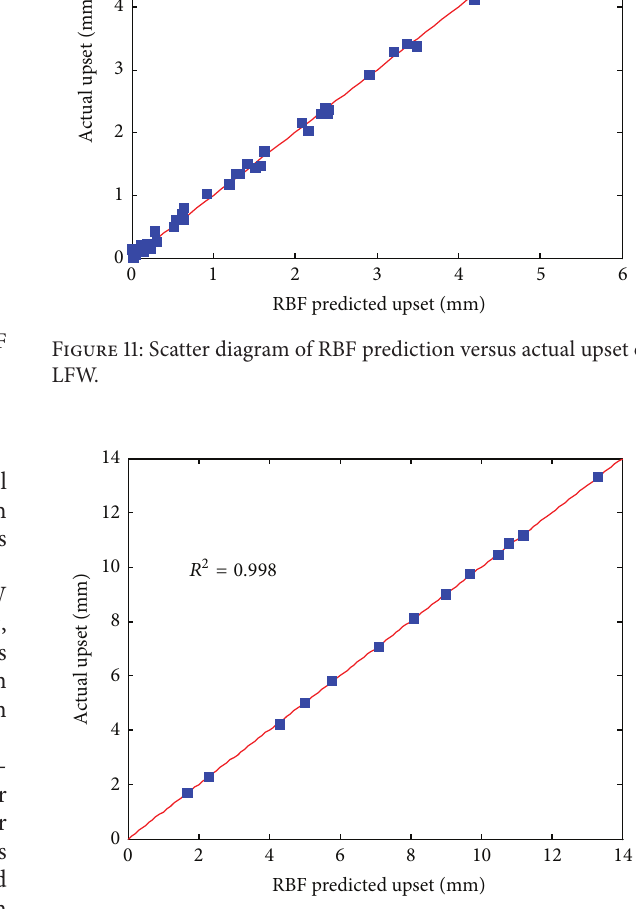
Figure 12: Scatter diagram of RBF prediction versus actual upset of